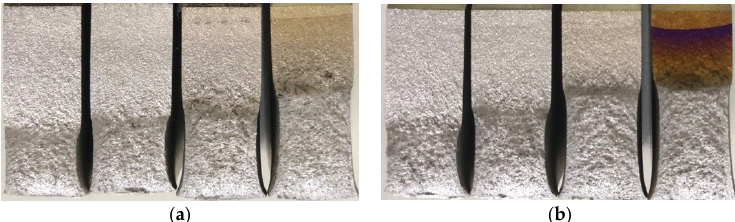
Figure 8. Diagrams of da/dN– ∆ K / E FCG curves of CP-Ti at different temperatures under high load ratio: ( a ) pure fatigue; ( b ) dwell fatigue.